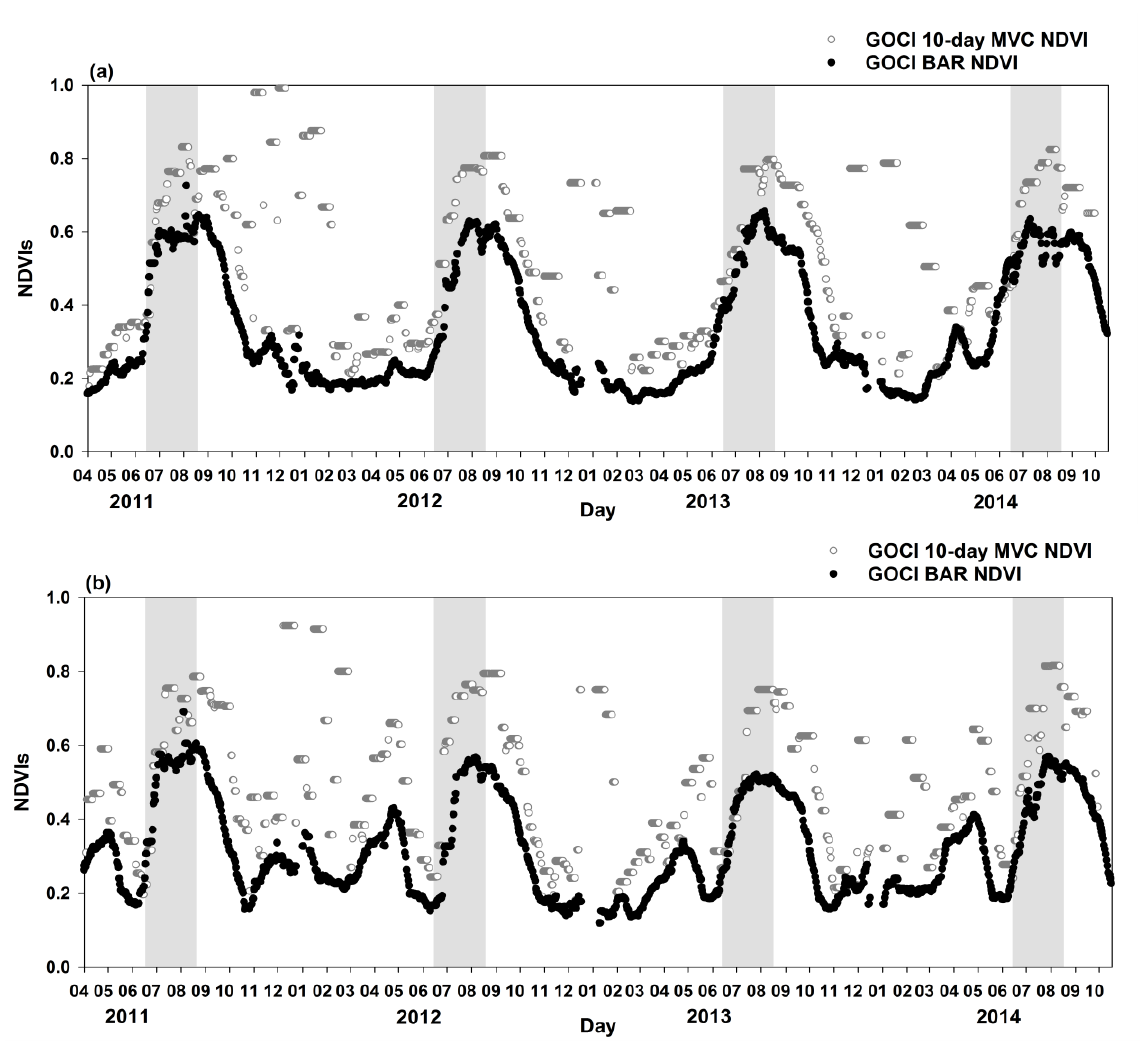
Figure 6. Comparison of the BAR NDVI and 10-day MVC NDVI from GOCI. Temporal variation in BAR NDVI (solid circles) and 10-day MVC NDVI (open gray circles) over intermediate-late-maturing paddy rice ( a ) and early paddy rice ( b ). The 4 number of light gray areas from middle June to middle August are rainy summer seasons in South